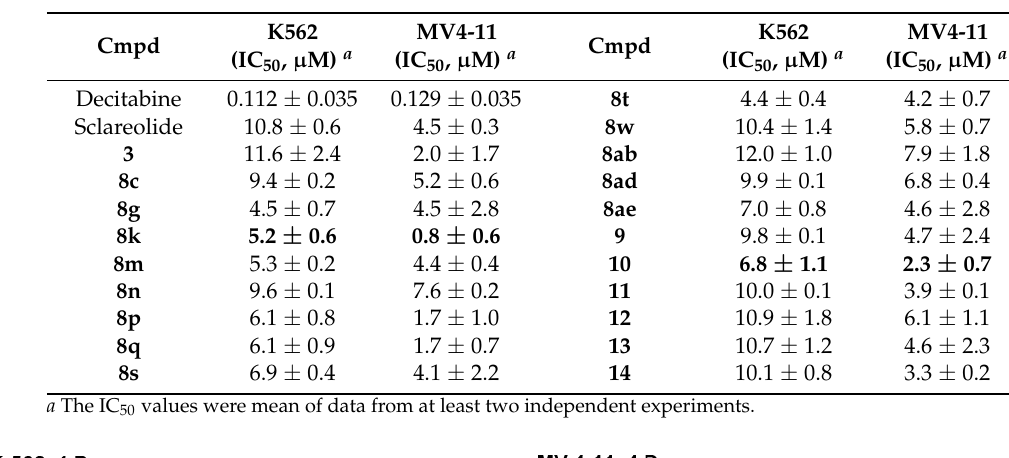
Table 3. Antiproliferative activities of sclareolide derivatives in K562 and MV4-11 cell lines.